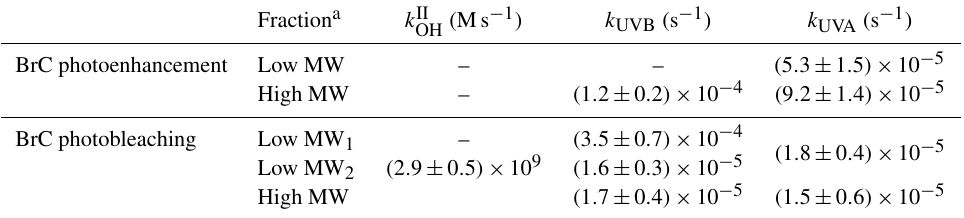
Table 1. Rate constants for the photoenhancement and photobleaching of low- and high-MW WS BrC of wood smoke, with respect to photolysis (UVB and UVA) and OH oxidation. Note that for UVB photolysis and OH oxidation, the reported uncertainties represent the variability ( ± 1 σ ) in multiple experiments ( n = 3) and that the rate constants for low-MW 1 and low-MW 2 BrC photobleaching correspond to chromophores that were rapidly and slowly photobleached, respectively. Rate constants for UVA photolysis were previously reported in Wong et al.